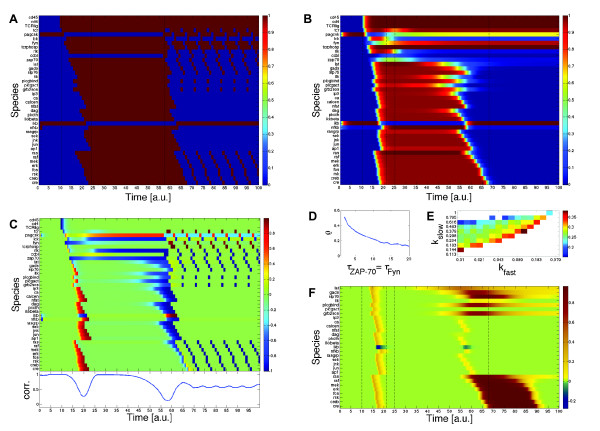
Results from the Boolean and continuous simulations of the T-cell model using the manually determined parameter set. The vertical dashed lines in (A, B, F) mark (from left to right): the switching on of the inputs, the total activation of the transcription factors, the activation of the feedback loops and the total deactivation of the transcription factors. (A) Boolean simulation using synchronous updates. (B) Continuous simulation using HillCubes. (C) Upper figure: difference between the time course from (A) and the time course from (B). Lower figure: correlation between the discrete and the continuous expression pattern of the lower 29 species at each time point 0 <t < 100. The curve was smoothened using a moving-average filter with 5 time-units window length. (D) Ratio of activation and deactivation time, ρ, for τFyn = τZAP-70 = 1, 2, ..., 20. Other parameters are set to n = 3, k = 0.3, τ = 1, kfast = 0.1 and kslow = 0.8. For τFyn = τZAP-70 = 1 the cascade was not activated properly. (E) Ratio of activation and deactivation time, ρ, for 20 different kfast and kslow. log10 (kfast) and log10 (kslow) are uniform from [-2, 0]. Other parameters are set to n = 3, k = 0.3, τ = 1, τFyn = τZAP-70 = 10. In the white areas the cascade was not activated properly. (F) Comparison between time course y(t) with the manually determined parameters and time course y3(t) with the decreased threshold in the activation of LAT-phosp by ZAP-70 as described in the section about monotony properties. Plotted is the difference y'(t) - y(t).